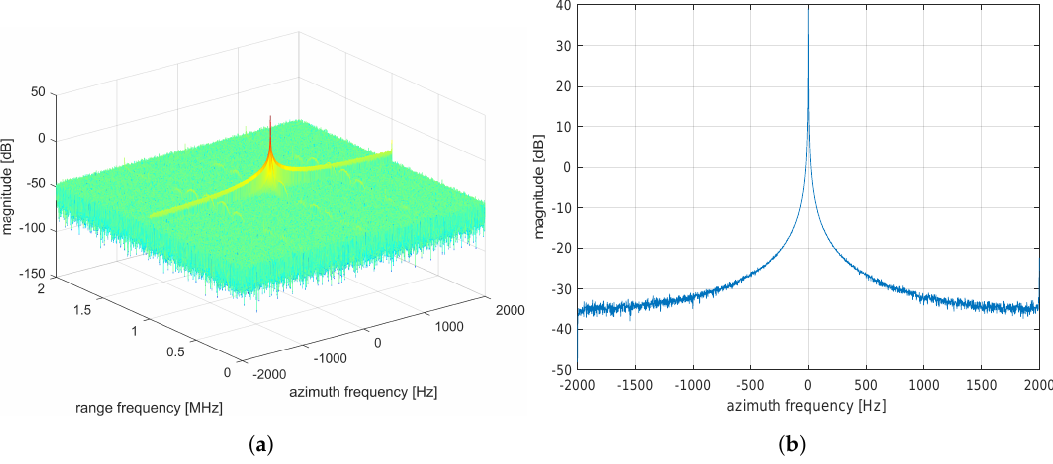
Figure 14. Azimuth spectrum after MCRA: ( a ) three-dimensional plot; ( b ) two-dimensional plot at target.